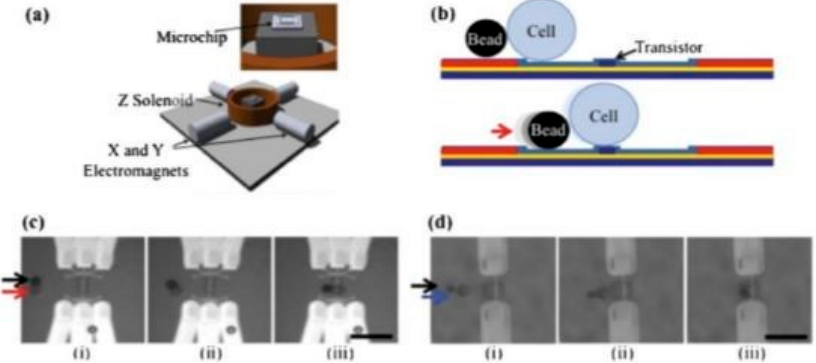
Figure 19. ( a ) Schematic of the magnetic bead setup utilized in [72]. The electromagnets generate a magnetic field, which rolls magnetic beads across the chip surface. ( b ) The beads are used to push the cells into position above the transistor. ( c ) An MCF-7 cell (red arrow) is moved from left to right by a bead (black arrow) to a position over a set of nanowires. ( d ) An HT-29 cell (blue arrow) is moved from left to right by a bead (black arrow) and positioned over a nanoribbon. Adapted with permission from [72]. Copyright 2013 Royal Society of Chemistry.